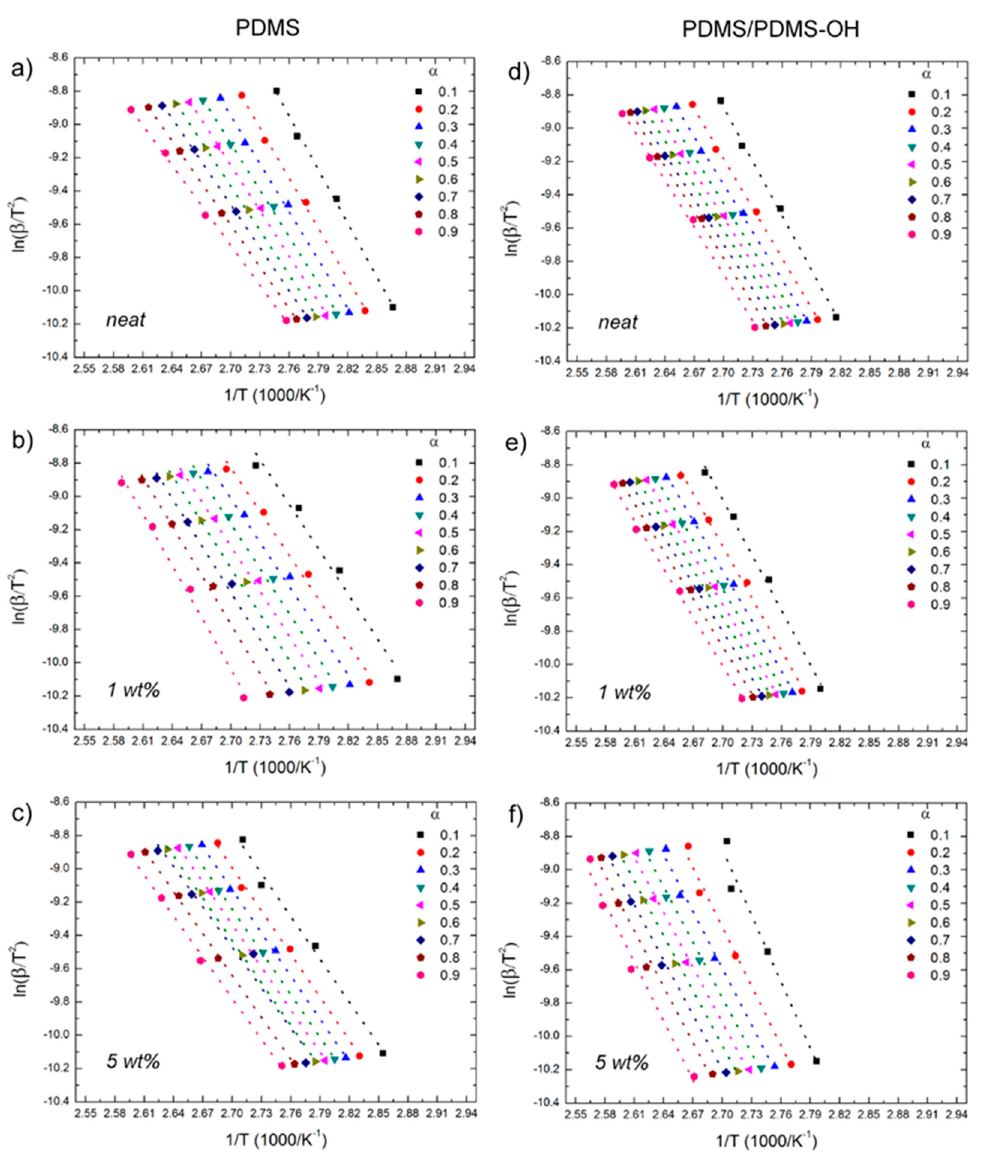
Figure 7. Plots of ln( β /T 2 ) versus 1/T at different extents of conversion according to the Kissinger–Akahira–Sunose model for nanocomposites with the PDMS and PDMS/PDMS–OH (75:25 w/w) matrix: ( a , d ) unfilled; ( b , e ) filled with 1 wt% GNP–DNA; ( c , f ) filled with 5 wt% GNP–DNA.